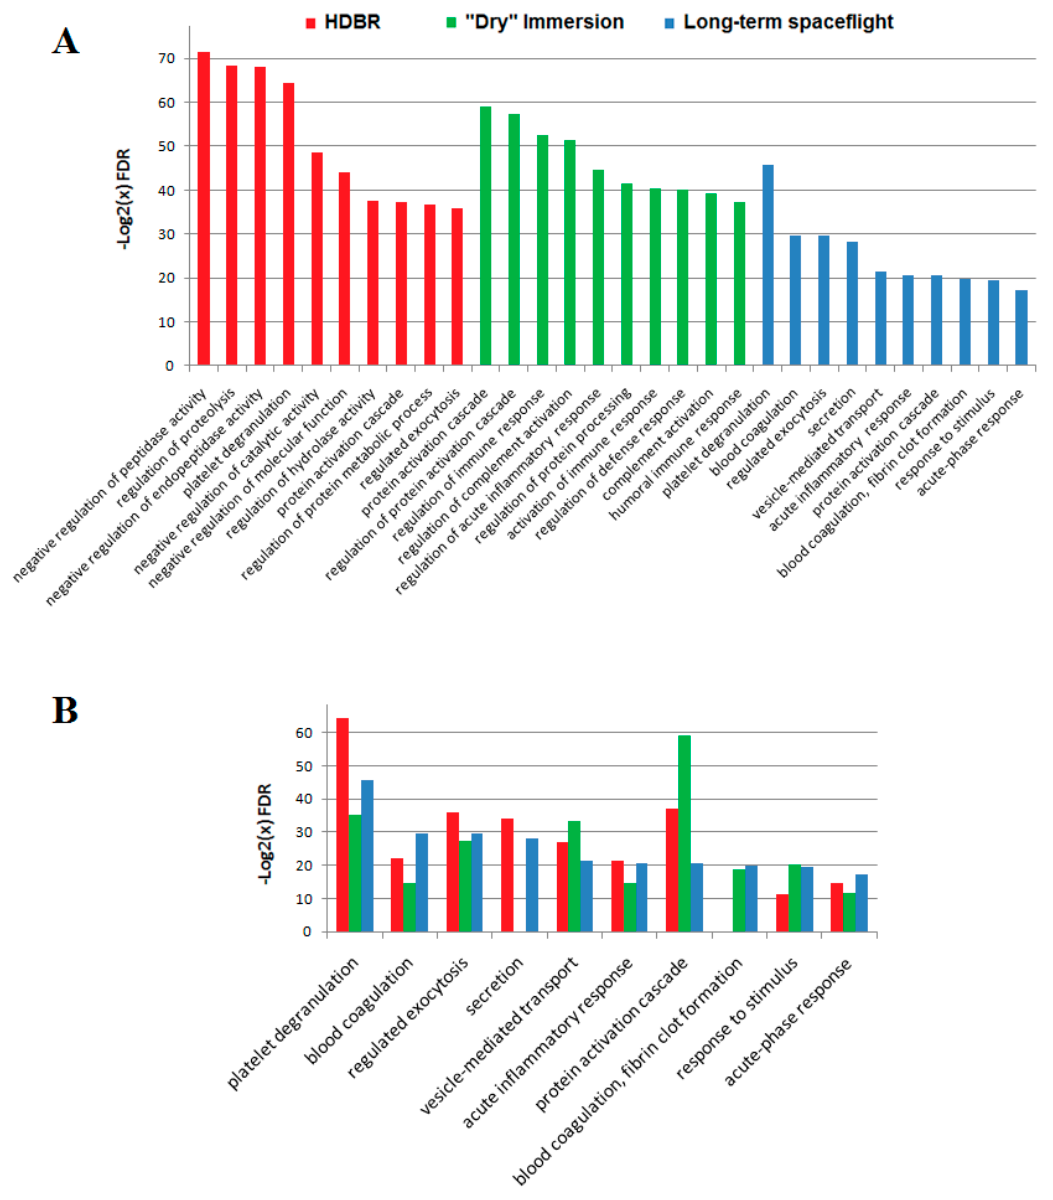
Figure 4. The histogram of gene ontology (GO) term enrichment in ground-based experiments and during spaceflight. ( A ) The list of the top 10 processes in which significantly changed proteins take part. ( B ) Comparison of the top 10 processes enriched on +1 days after landing with similar processes in HDBR and Dry immersion. The ordinate represents the enriched GO terms, and the abscissa represents the − log2(FDR).